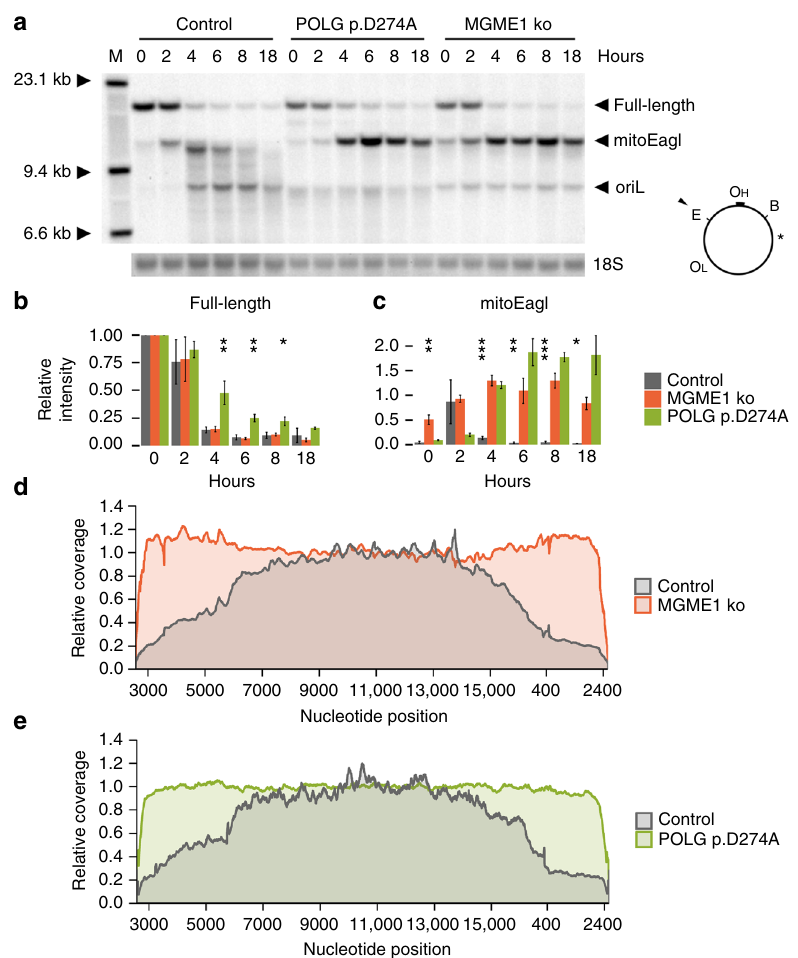
Fig. 1 Degradation of linearized mtDNA in control and mutant mitoEagI-expressing HEK 293 cells. a Southern blot showing the degradation of mtDNA within the fi rst 18 h of induced expression of mitoEagI (E) in control, MGME1 p.I9Qfs*32 knockout ( ‘ MGME1 ko ’ ), and exonuclease-de fi cient POLG ( ‘ POLG nuclear 18S ribosomal DNA ( ‘ 18S ’ ). Note that persistent bands with one end in the vicinity of oriL in MGME1 ko and mutated POLG cells are already present before induction (time point ‘ 0 ’ , lowest arrowhead). These linear mtDNA species are due to leaky mitoEagI expression and their presence is not related to the induced massive double-strand breaks. b Quanti fi cation of full-length mtDNA con fi rms the ef fi cient cleavage of mtDNA by mitoEagI and ( c ) the persistence of mitoEagI-linearized mtDNA in MGME1 ko and POLG p.D274A cells. Band intensities were fi rst normalized to 18S ribosomal DNA intensities then to intensities of the full-length mtDNA in each cell line before induction. Error bars represent standard errors of the mean (SEM) in three independent experiments (including both available MGME1 knockout clones). Signi fi cance was calculated by applying one-way ANOVA test. * P < 0.05, ** P < 0.01, *** P < 0.001. d , e Coverage ratios throughout the mitochondrial genome as determined by ultra-deep sequencing of mtDNA from cells 6 h after induced mitoEagI expression and normalized to values in non-induced cells. In control (gray), coverage ratio is the lowest around the mitoEagI cutting site (represented by the two ends of the x -axis) and gradually increases in both directions before reaching full coverage. In MGME1 ko cells ( d , red) and in cells with exonuclease-de fi cient POLG ( e , green), coverage ratio drops only in the immediate vicinity of the mitoEagI cutting site. Note that library preparation techniques used for ultra-deep sequencing result in underrepresented positions in the close vicinity of free DNA